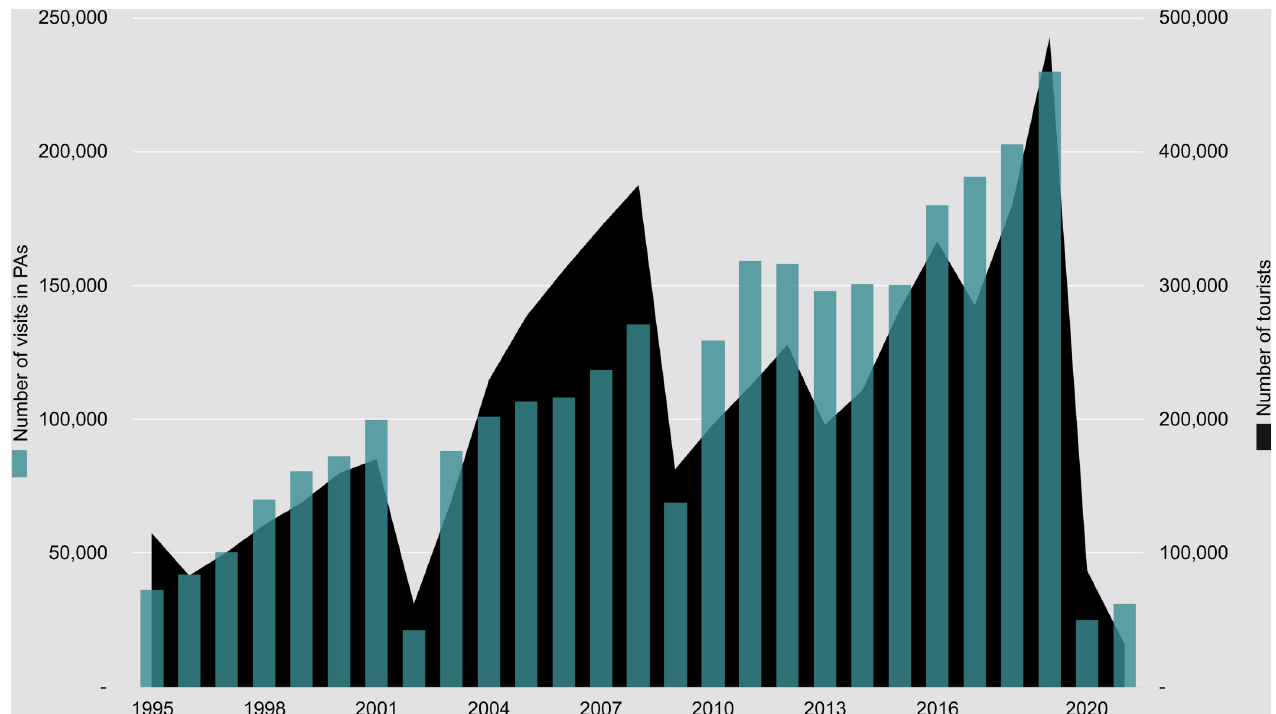
Fig 4. Madagascar tourists and PA entry tickets. Total number of tourists entering Madagascar VS. number of visits in parks and reserves under MNP management.